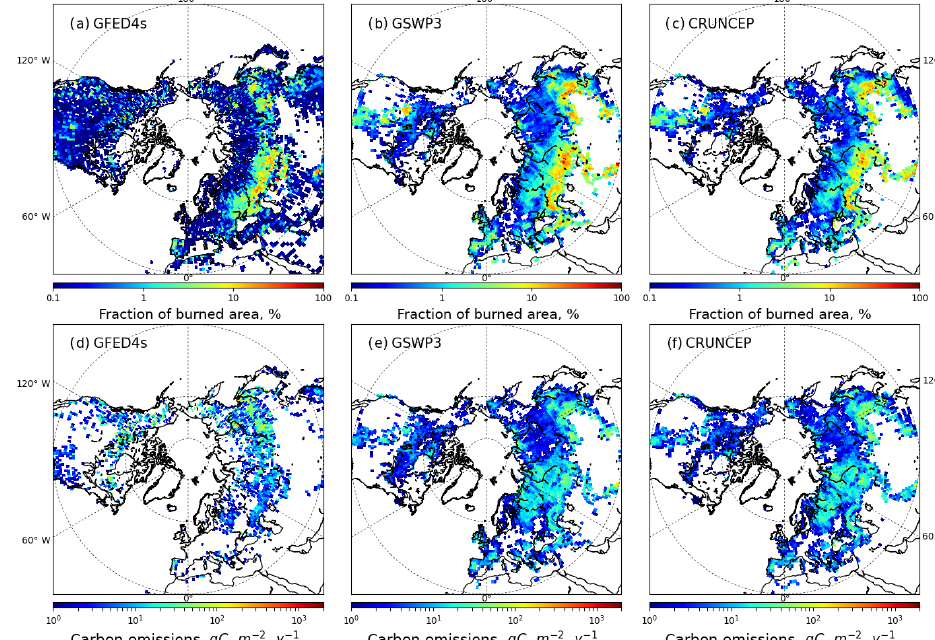
Figure 18. (a–c) Mean annual fractional burned area (%) from (a) satellite observation in GFED4s and (b) GSWP3 and (c) CRUNCEP-forced simulations. (d–f) Mean annual carbon emissions from natural fires (gCm − 2 yr − 1 ) from (d) satellite observation in GFED4s and (e) GSWP3 and (f) CRUNCEP-forced simulations, averaged over the period 1997–2007. The burned area fraction simulated from ORCHIDEE-MICT is corrected for the omission of cropland fires in the